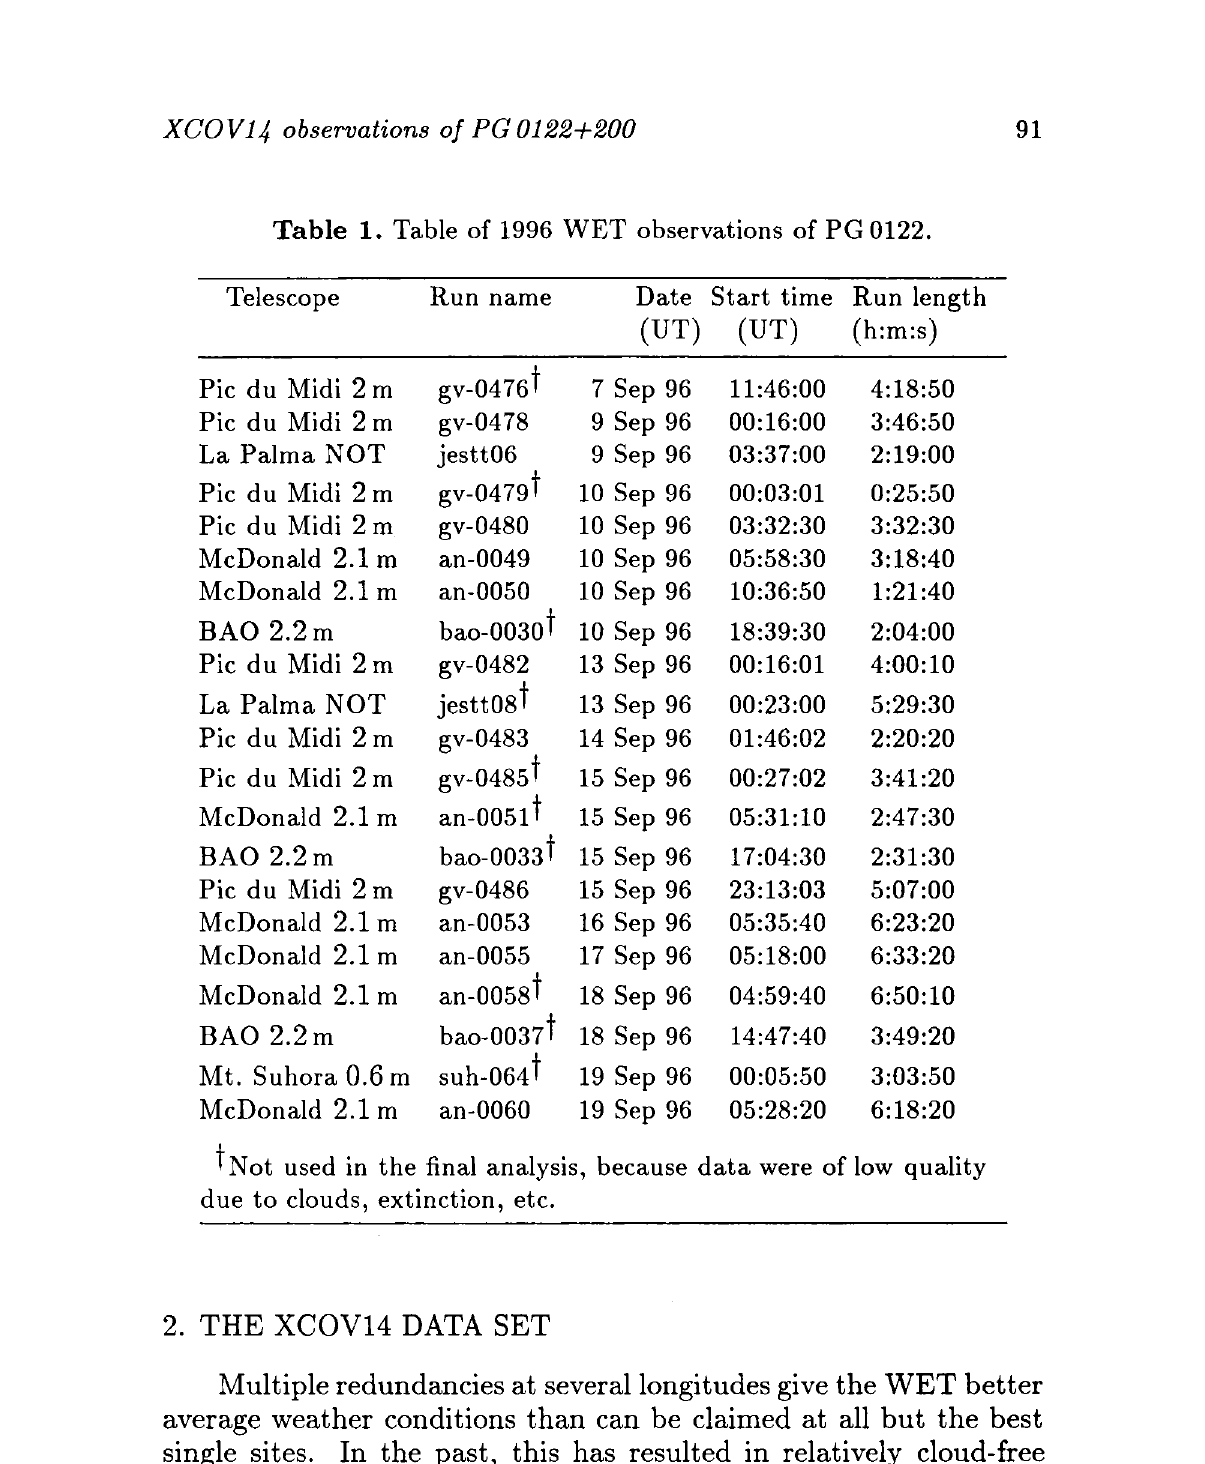
Table 1. Table of 1996 WET observations of PG